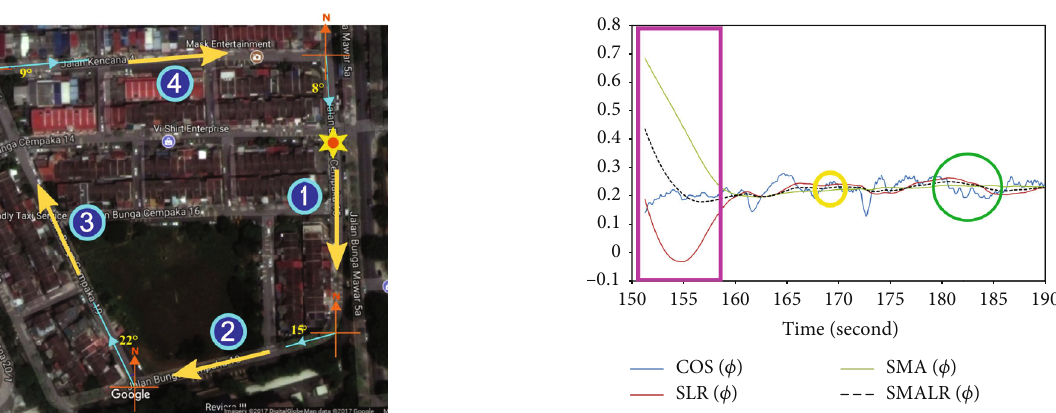
Figure 6: Driving path of the digital compass experiment.